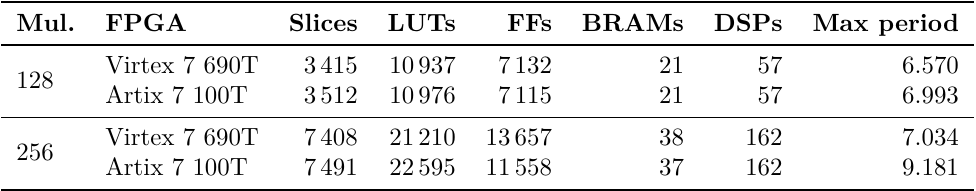
Table 2: Resources required for the Carmela128 and Carmela256 -based architectures on several platforms. The max period is measured in nanoseconds (ns).